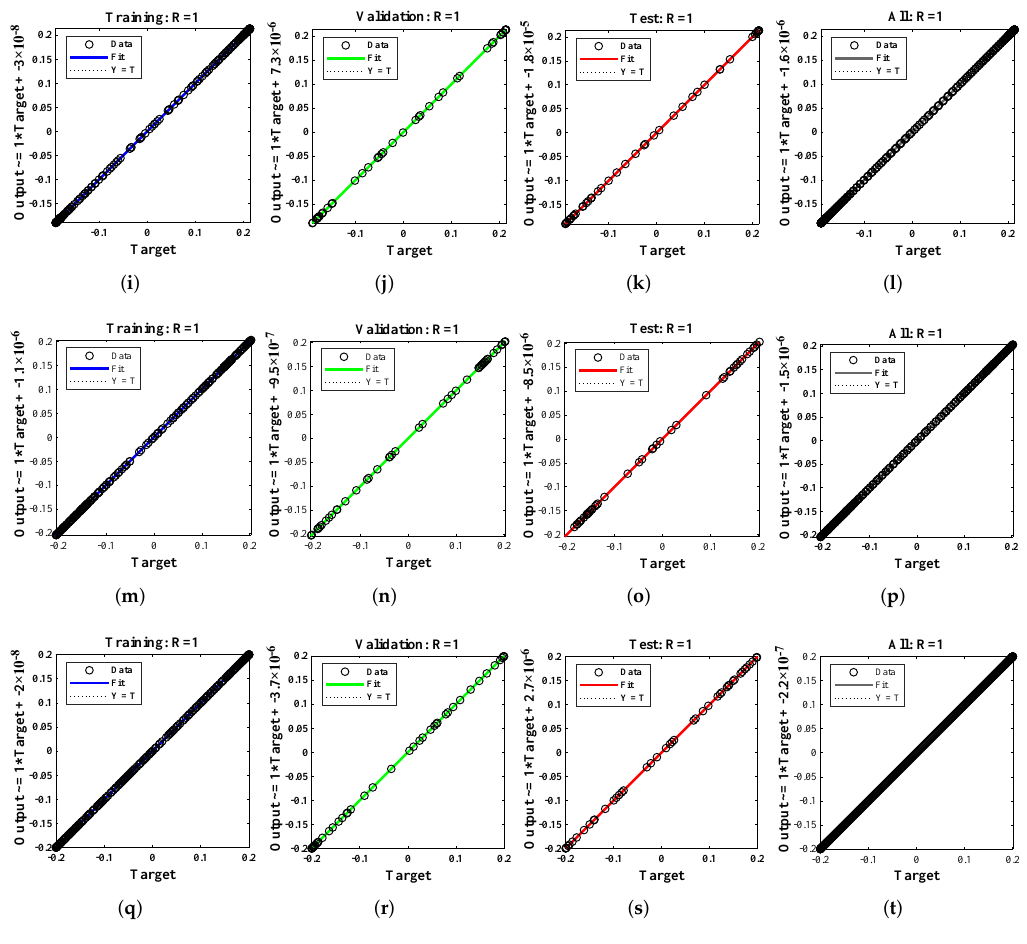
Figure 13. Regression analysis of Examples 1 and 2.